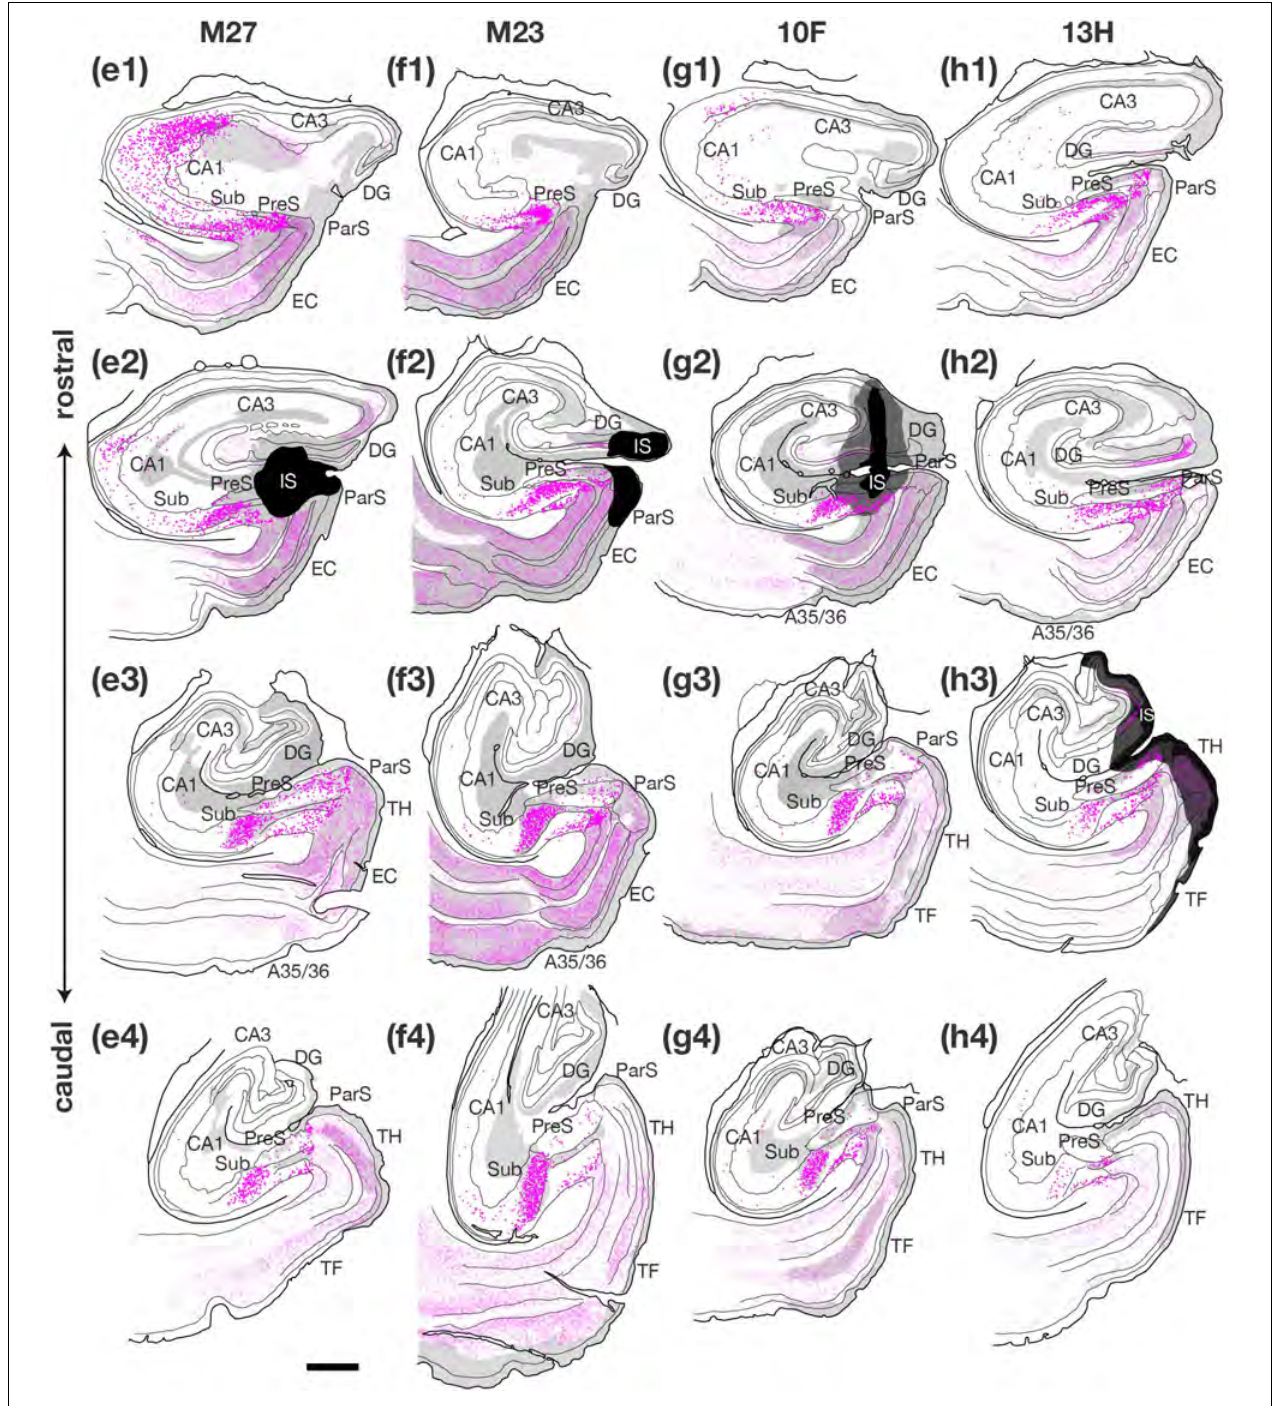
FIGURE 3 | Plotting of retrogradely labeled cells in the hippocampal and parahippocampal areas on the ipsilateral side of the injection site of CTB. Sections in each case are presented from rostral (1) to caudal (4) levels at 1- to 3-mm intervals as indicated in the unfolded maps in Figure 2 . Dark magenta dots represent single retrogradely labeled cells in CA1, Sub and PreS, and pale magenta dots indicate single labeled cells in the other regions. Injection sites and their diffusion are indicated by black and dark gray portions, respectively. Regions of anterograde label distribution are represented by light gray portions. Scale bar = 1 mm. A35/36, areas 35 and 36 (the perirhinal cortex); CA, cornu ammonis; DG, dentate gyrus; EC, entorhinal cortex; IS, injection site; ParS, parasubiculum; PreS, presubiculum; Sub, subiculum; TF, area TF; TH, area TH. Note that many labeled cells were distributed along the rostrocaudal axis in the cases where CTB injection extended to all layers of PreS (cases M25, 09D, 09E, M29, and M27). On the other hand, fewer labeled cells were observed in CA1 in the cases where CTB injection did not extend to the deep layers of PreS (cases M23, 10F, and 13H). Note also that many labeled cells were distributed in Sub and PreS along the rostrocaudal axis in all cases.